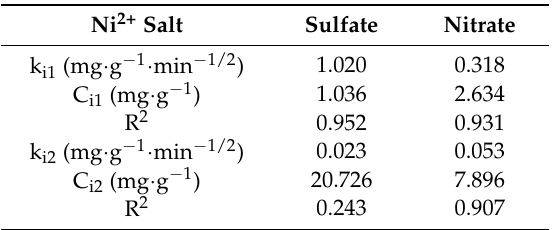
Table 3. Kinetic parameters from intra-particle diffusion model for the adsorption of nickel from nickel sulfate and nickel nitrate solutions.